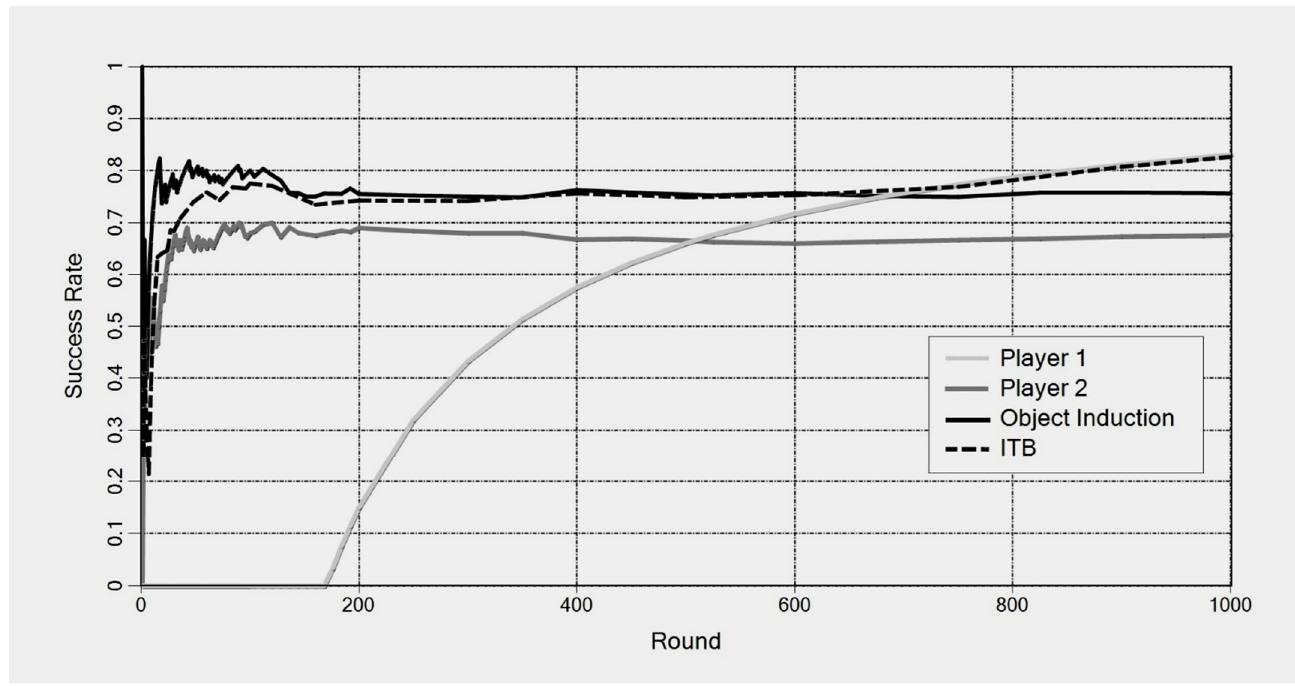
Figure 1. Simulation of a prediction game with ITB, OI and two alternative players, predicting a binary random sequence with P(e = 1) = 2/3. (Programmed by Paul Thorn.)